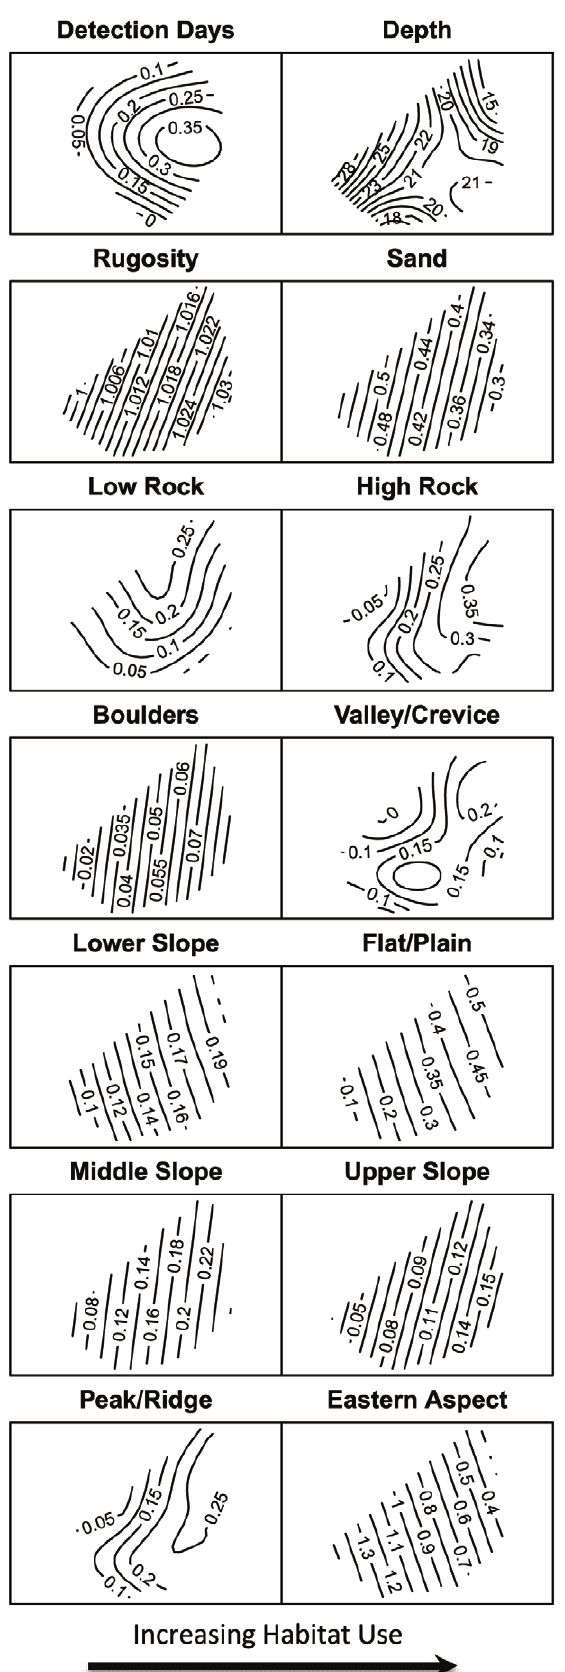
Figure 3. Ordination Plots. Non-metric multidimensional scaling (NMS) ordination with fitted regression surfaces that describe the responses of green sturgeon hydrophone detections to habitat variables in the Siletz Reef array. The isolines represent the predicted smooth trends by general additive model (GAM) between environ- mental variables and plot scores. We rotated NMS plots to maximize the linear correlation of sturgeon detection-days with NMS horizontal axis (axis 1) scores from left to right. Sturgeon presence at the hydrophones therefore tends to increase from left to right along the horizontal axis. Negligible variance in sturgeon presence is represented on the vertical axis (axis 2). We omitted NMS plot score points to improve clarity.